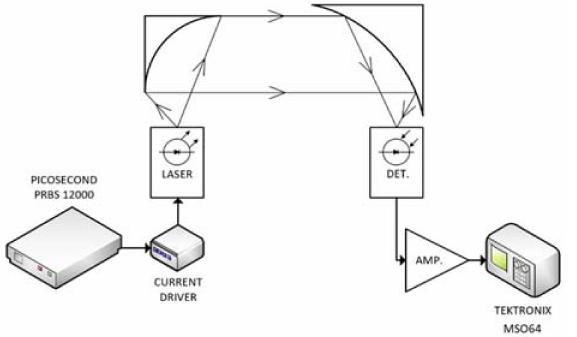
Figure 7. The block scheme of the OWC lab system with the testing setup (DET.—MCT photodetector, AMP.—detector